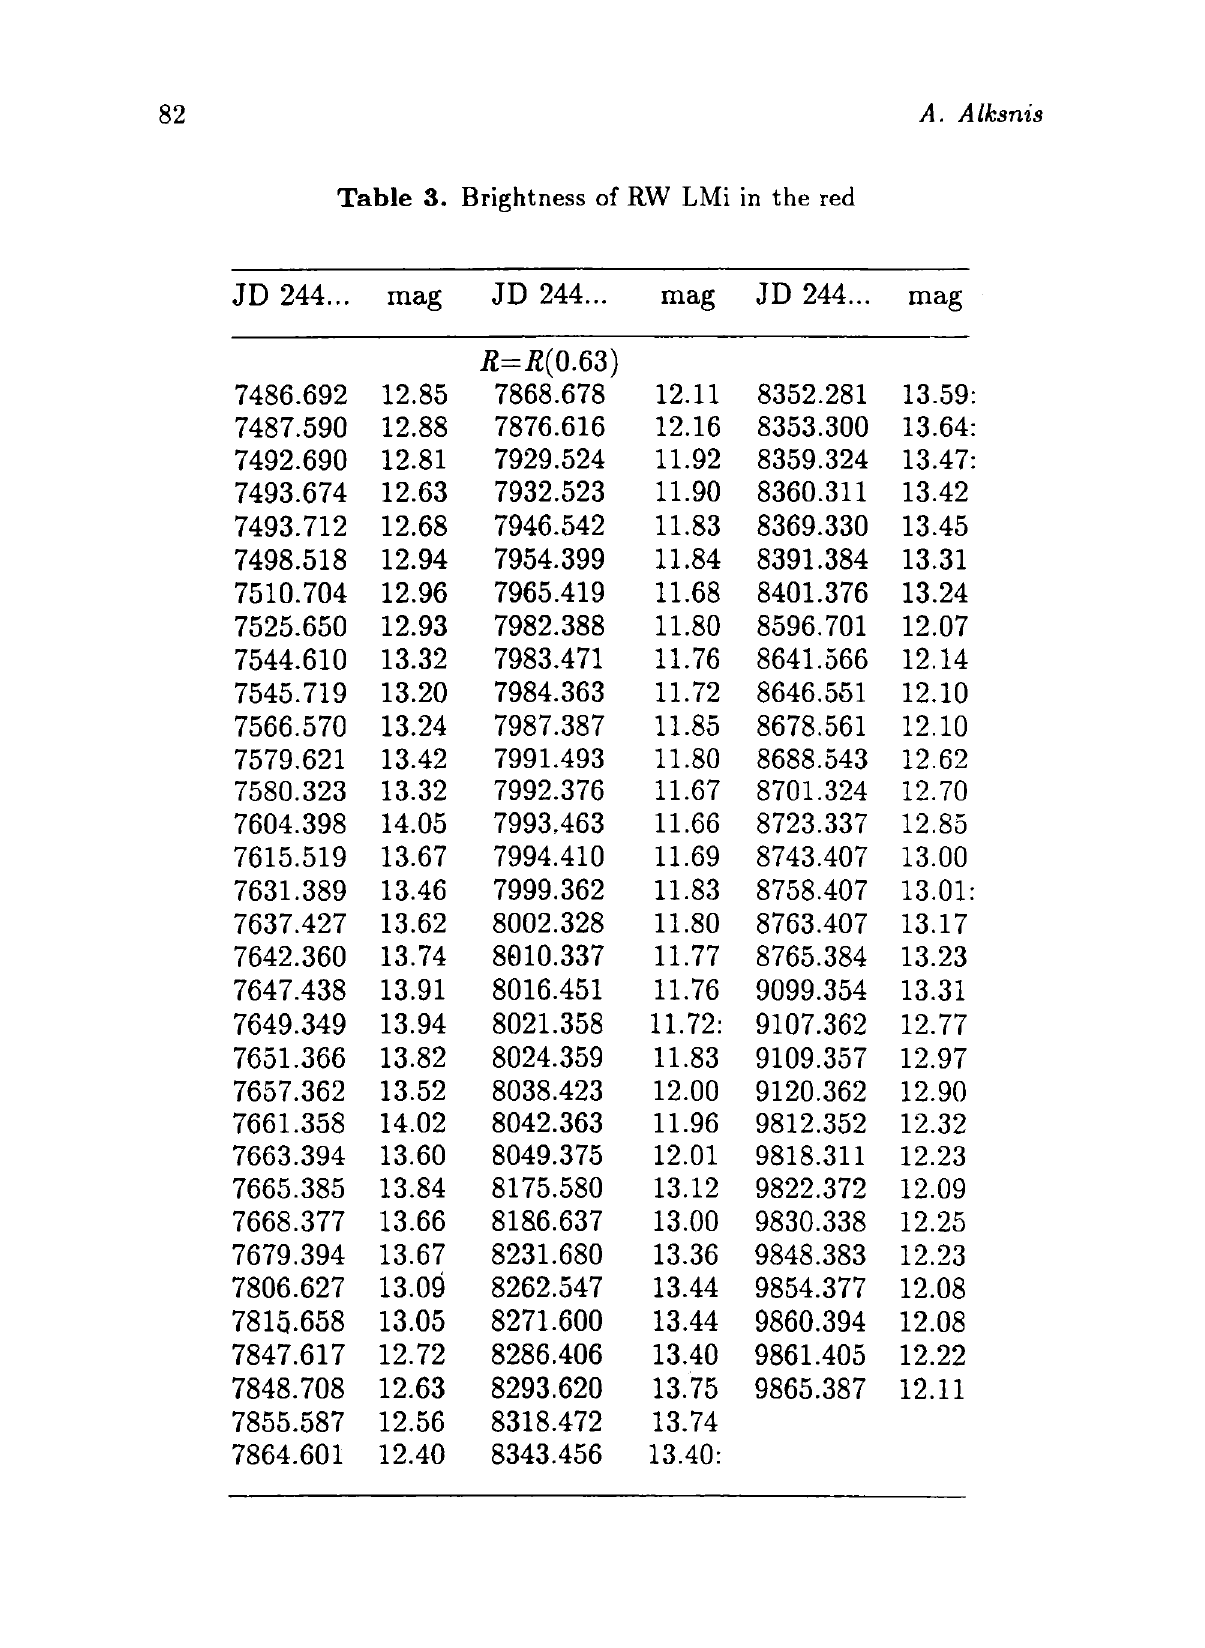
Table 3. Brightness of RW LMi in the